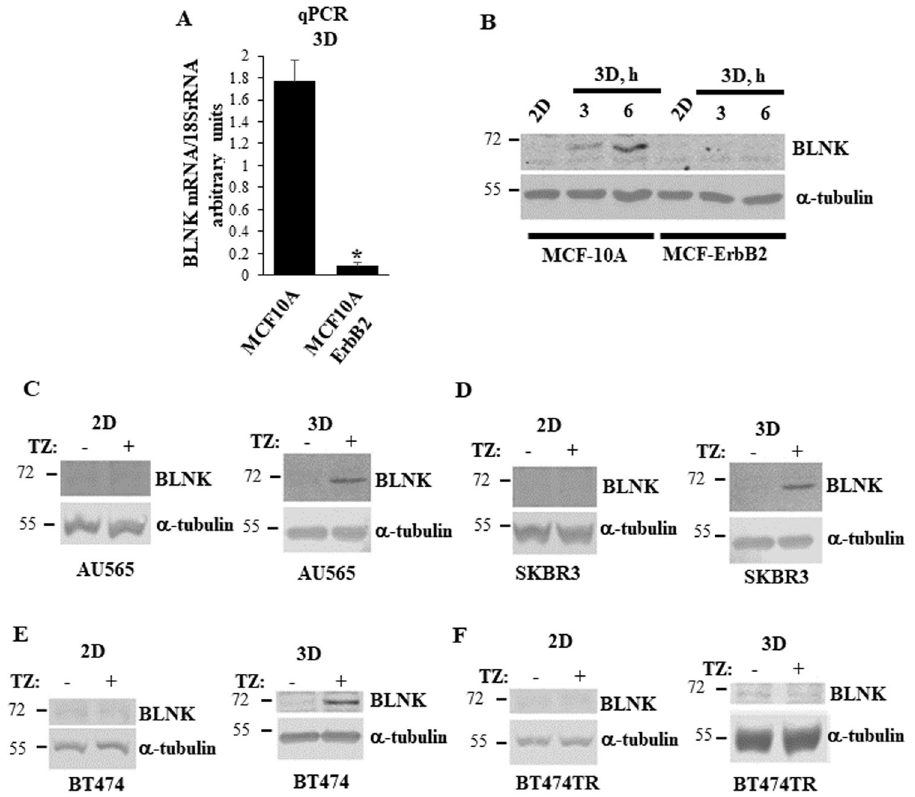
Fig. 1 ErbB2 downregulates BLNK in detached breast cancer cells. A MCF10A and MCF-ErbB2 cells were cultured detached from the ECM (3D) for 24 h and BLNK mRNA levels were analyzed in the cells by quantitative PCR (qPCR). BLNK mRNA levels normalized by those of 18 S rRNA (determined by qPCR) expressed in arbitrary units are shown. Results represent the average of three independent experiments plus the SD. * p -value is < 0.05. B MCF10A and MCF-ErbB2 cells were cultured attached to (2D) or detached from (3D) the ECM for the indicated times and assayed for BLNK levels by western blotting. α -tubulin was used as a loading control. C – E Human ErbB2-positive cell lines AU565, SKBR3 and BT474 were cultured attached to (2D) (left) or detached from the ECM (3D) (right) for 48 h in the absence ( − ) or in the presence ( + ) of 5 μ g/ml trastuzumab (TZ) and assayed as in ( B ). F Trastuzumab-resistant variant of BT474 cells BT474TR was assayed as in ( C – E ).